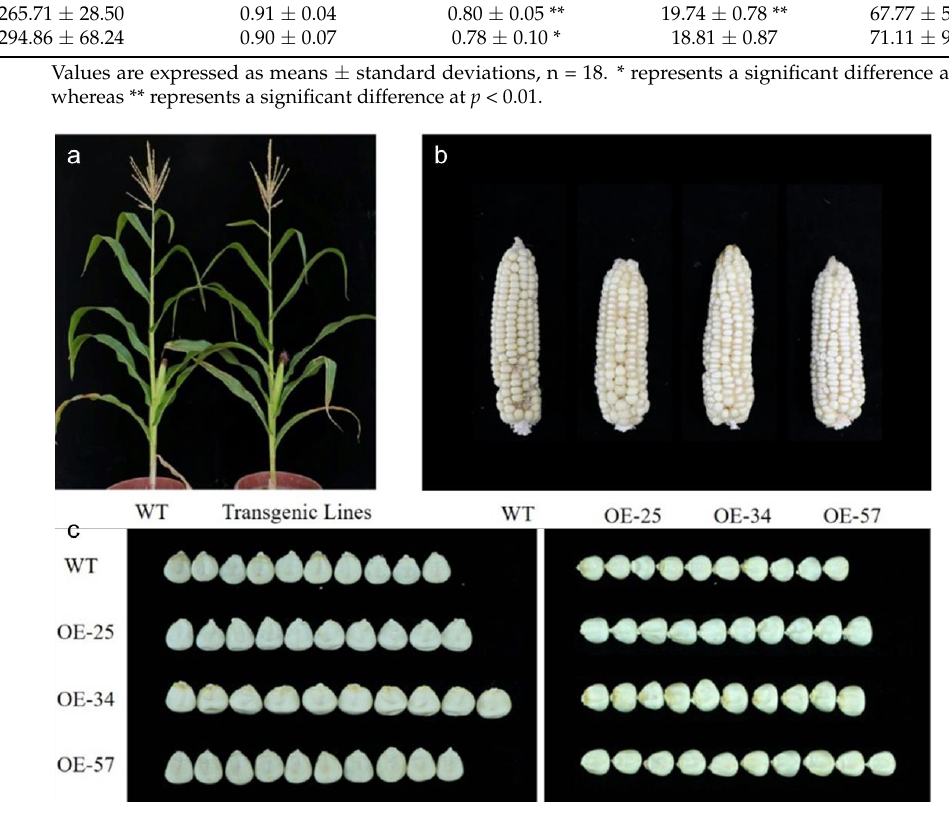
Figure 2. Phenotypic analysis of GS5 transgenic maize. ( a ) Comparison of plant height at maturity of transgenic plants. ( b ) Comparison of ears of transgenic plants. ( c ) Comparison of kernel morphology of transgenic plants.